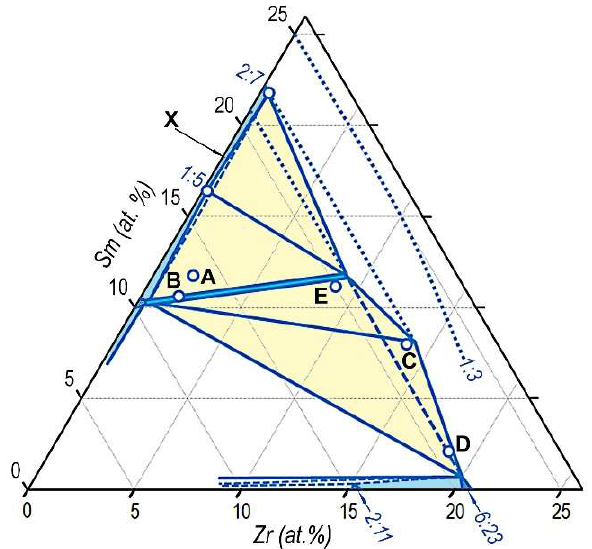
Figure 10. Sketch of the 3d-TM angle of the quasi-ternary (Co,Cu,Fe)–Sm–Zr phase diagram for a temperature range of 1160–1190